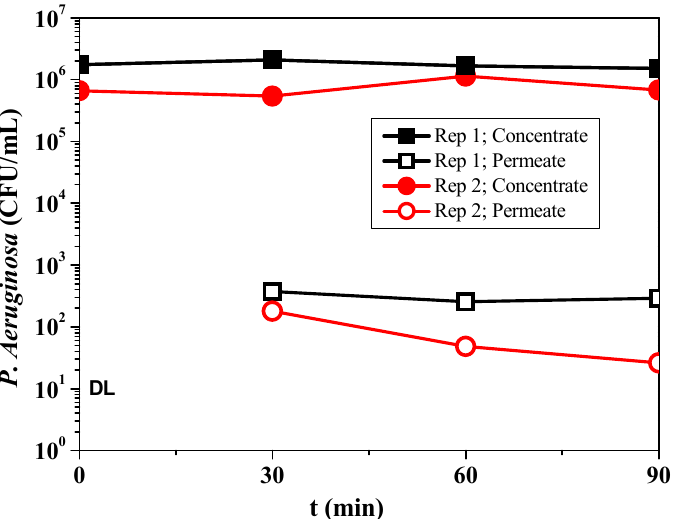
Figure 9. Retention of P. Aeruginosa in self-cleaning photocatalytic membranes with an initial concentration of 1 × 10 6 CFU/mL in natural water (Tabernas, Spain). Detection limit (DL) = 10 1